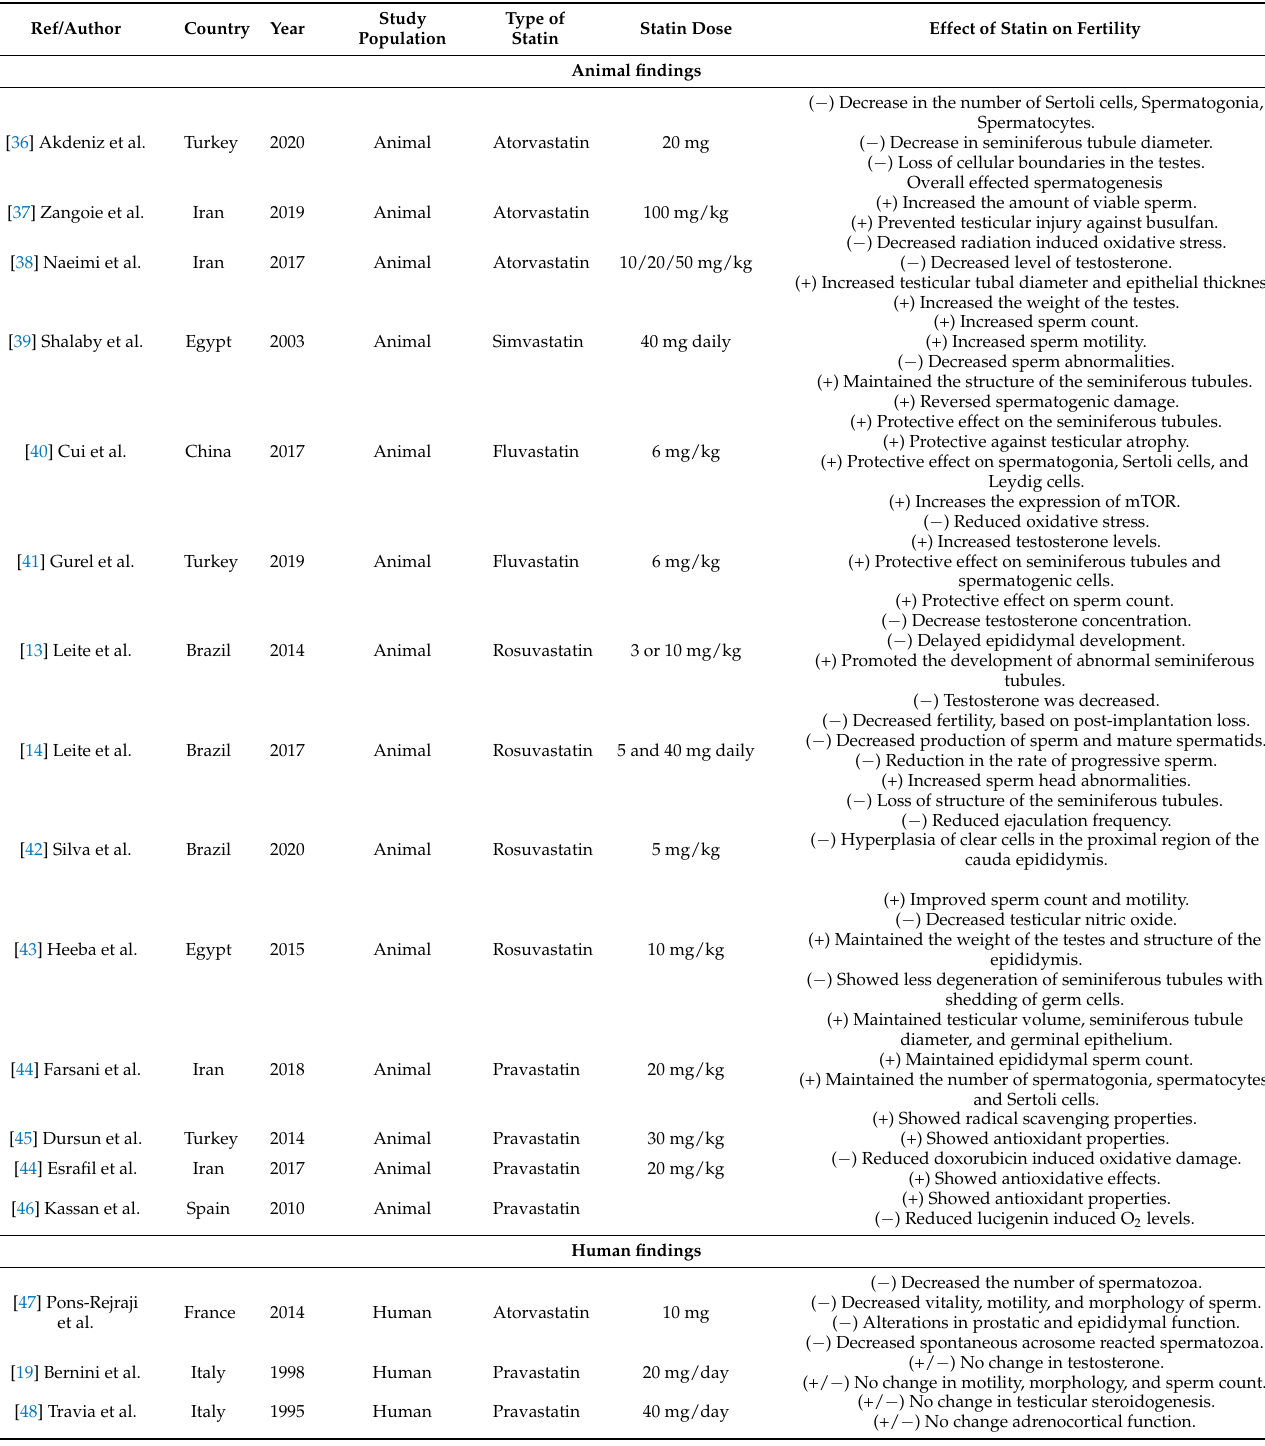
Table 1. Summary of studies that evaluated the effect of statins on male reproductive